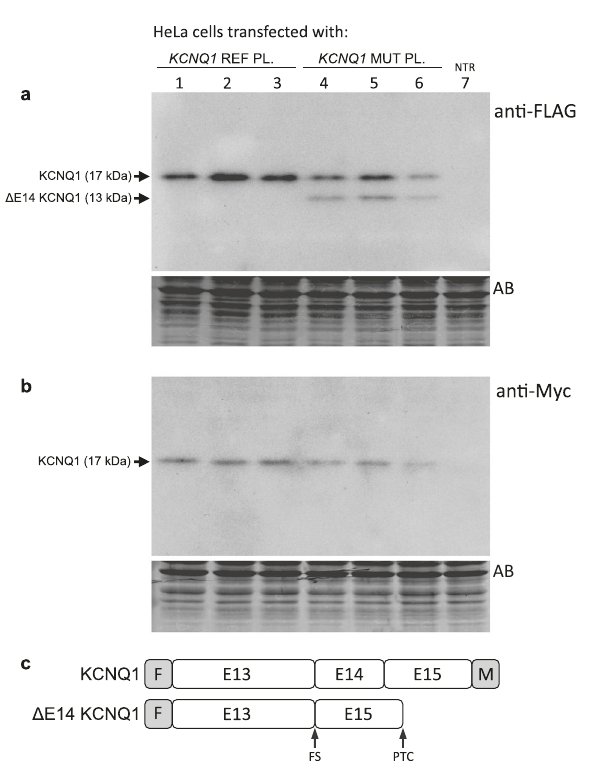
Fig. 7 Western blot analysis of HeLa cells transfected with KCNQ1 c.1686 − 9 T > C minigene plasmids. KCNQ1 Reference (REF) or Mutant (MUT) minigene plasmids (PL) were transfected into HeLa cells (in triplicated wells) as indicated. Cell lysates, derived from the same experiment and processed in parallel, were analyzed by western blotting with mouse monoclonal anti-FLAG ( a ) or anti-Myc ( b ) antibodies 48 h after transfection. NTR nontransfected cells, AB membrane stained with Amido Black 10B after immunostaining. c Structure of minigene-derived KCNQ1 and Δ E14 KCNQ1 proteins as predicted by sequence analysis of the corresponding cDNAs. F FLAG epitope, M Myc epitope, FS Frameshift, PTC premature termination